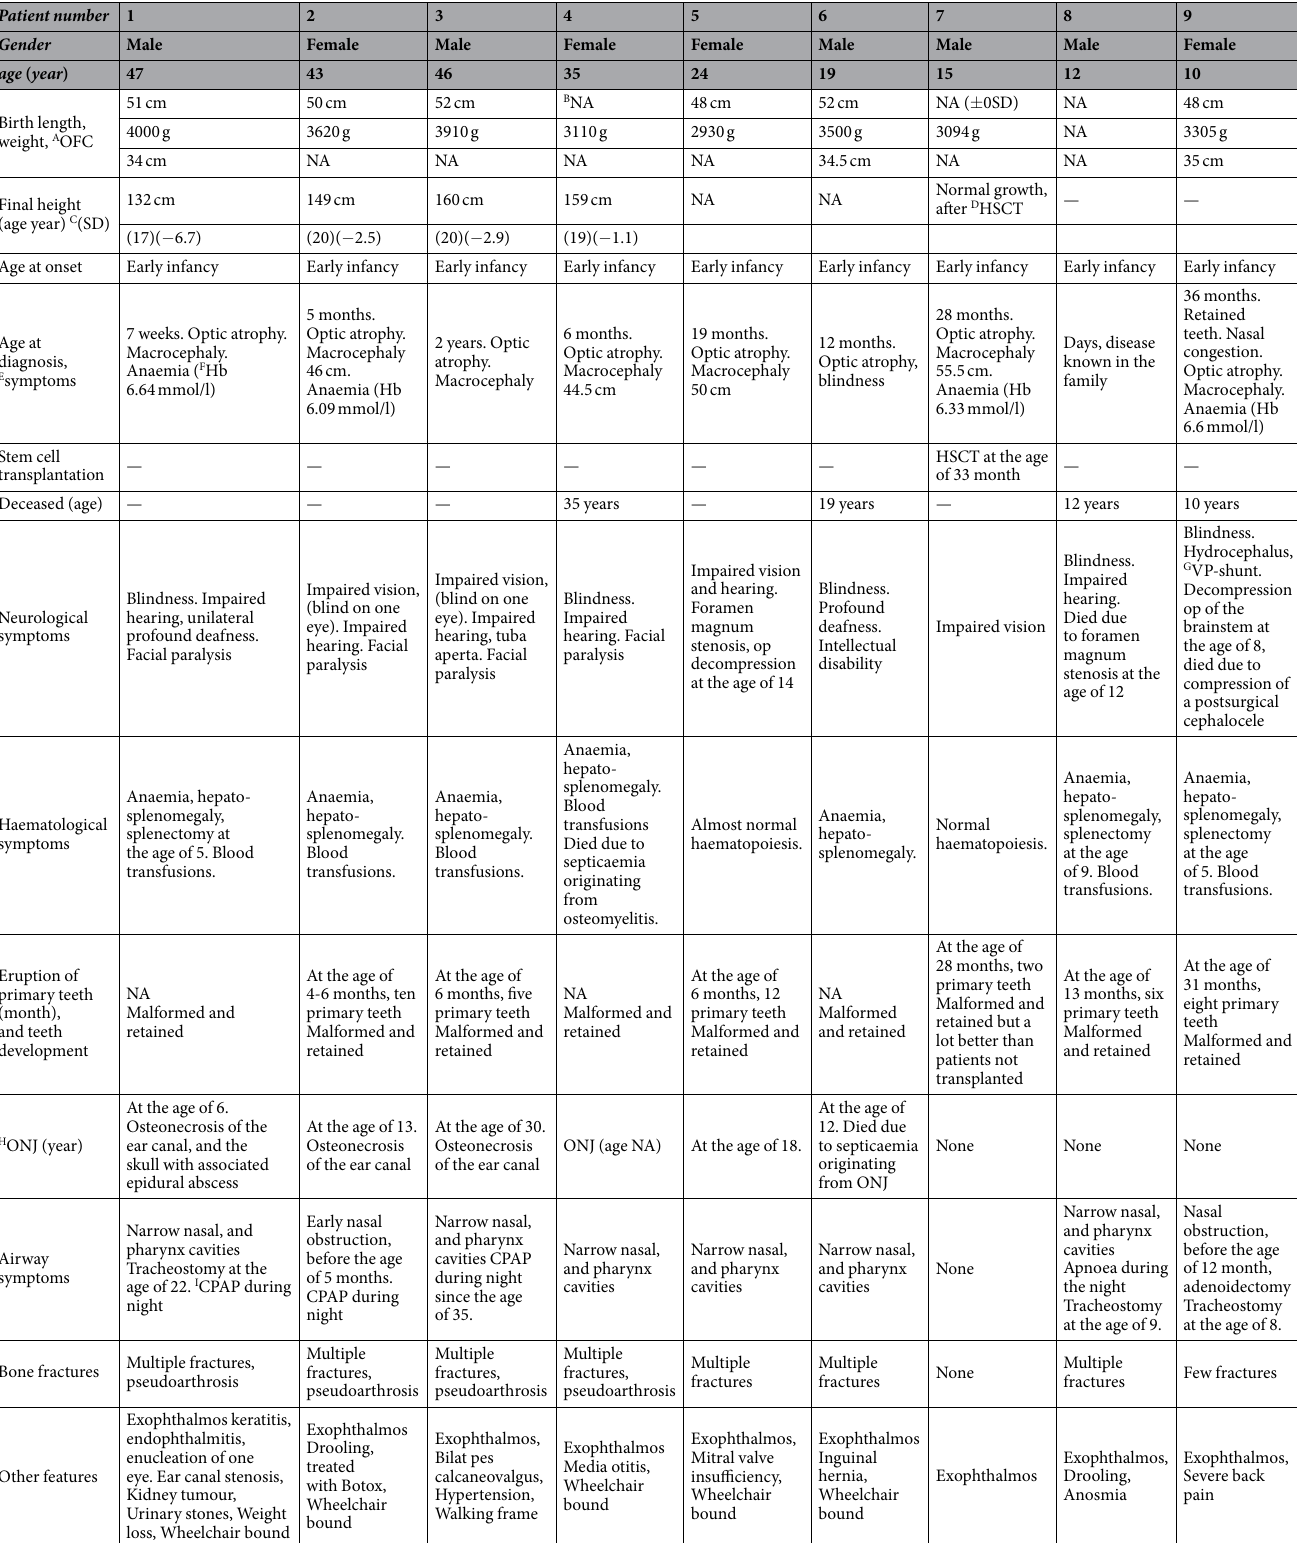
Table 1. Clinical features of nine individuals with a splice site mutation in the SNX10 gene, and intermediate autosomal recessive osteopetrosis (IARO). A OFC = occipital-frontal circumference. B NA = Not available. C SD = Standard deviations. D HSCT = hematopoietic stem cell transplantation. E Symptoms that lead to the diagnosis. F Hb = hemoglobin. G VP = ventriculo-peritoneal shunt. H ONJ = osteonecrosis of the jaw. I CPAP = continuous positive airway